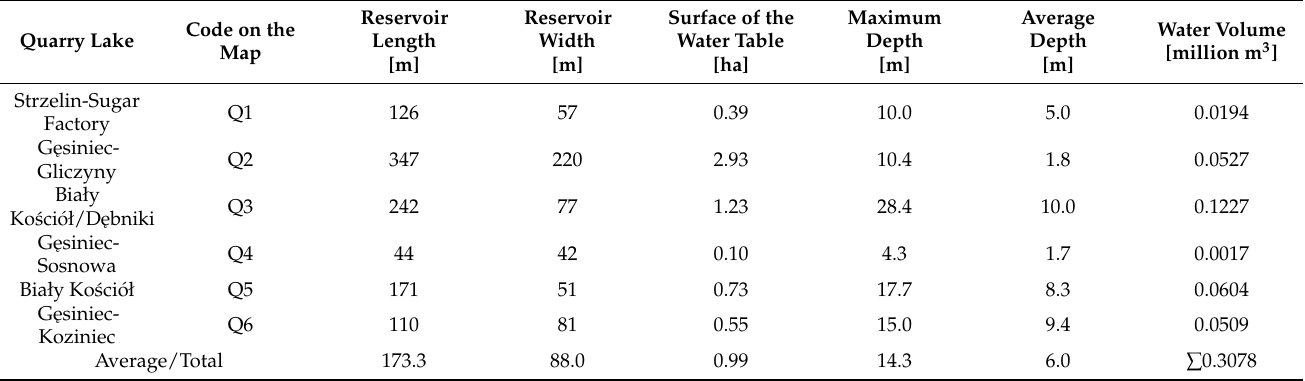
Table 2. Characteristics of the selected bathymetric and morphological parameters of the analysed quarry lakes (author